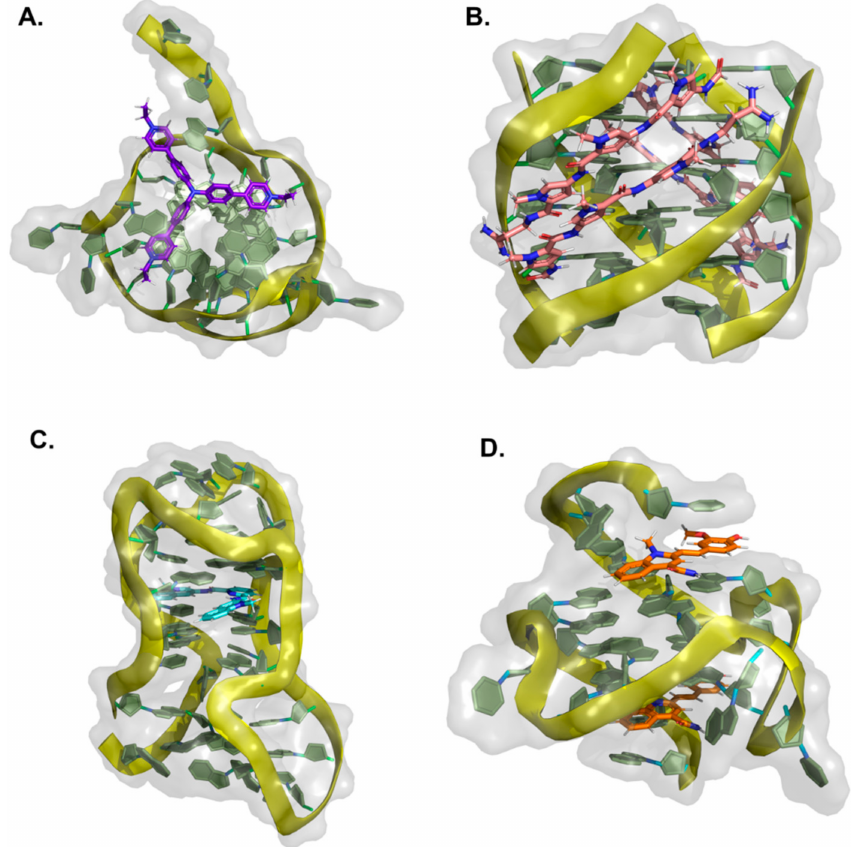
Figure 11. Structural representations of the complexes between G4s (represented as cartoon and transparent surface) and ( A ) a NBTE probe (PDB 6KFJ), ( B ) distamycin A (PDB 2JT7 ]), ( C ) PDC-360A (PDB 6SX3 ]) and ( D ) PEQ (PDB 7KBX) which are represented with coloured